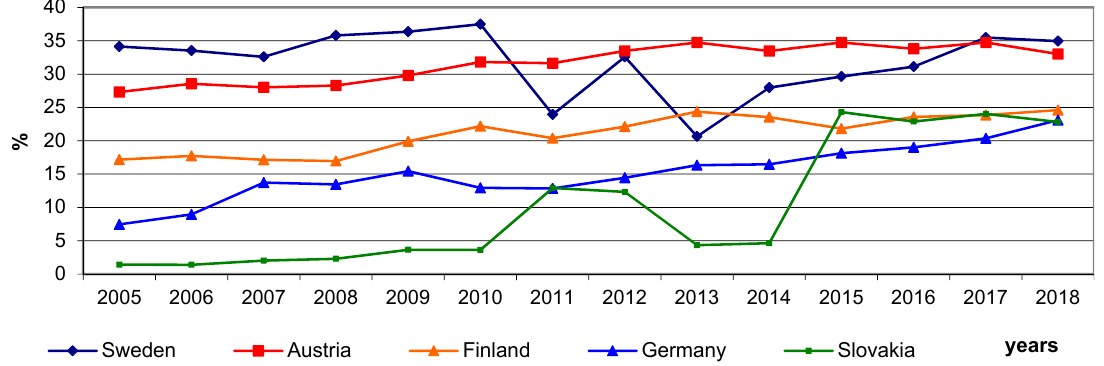
Figure 12. Top 5 EU countries in share of renewable energy in the total energy use in agriculture in the in 2005–2018. In the next stage, the dynamics indicators for the basic groups of energy sources were calculated. The 2005 level was adopted as the basis (Table 2). Over 14 years, the increase in energy consumption in agriculture was recorded in 11 EU countries, by far the largest in Romania, and significant in Latvia, Germany, and the United Kingdom. In turn, substantial declines occurred in Greece, but also significant in Bulgaria, Sweden, Ireland, and Portugal. The reason for the drops may be the limitation of agricultural production or the use of more effective technology. In turn, when energy consumption increases, the reasons are the opposite. Each country should be analyzed separately due to the natural, eco- nomic, and social conditions. In the case of Greece, a substantial reduction in oil consump- tion can be observed, which may be related to the cessation or reduction of many agricul- tural production. Increase in this country was recorded in the case of the consumption of renewable energy sources. In Romania, all energy sources’ consumption, except for fossil